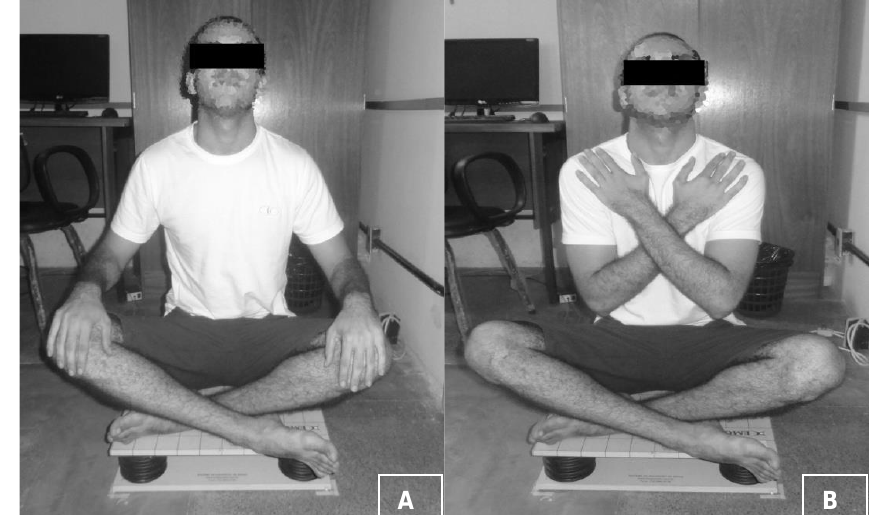
Figura 1. Teste de equilíbrio do tronco com braços apoiados nos joelhos (A) e braços cruzados no peito e